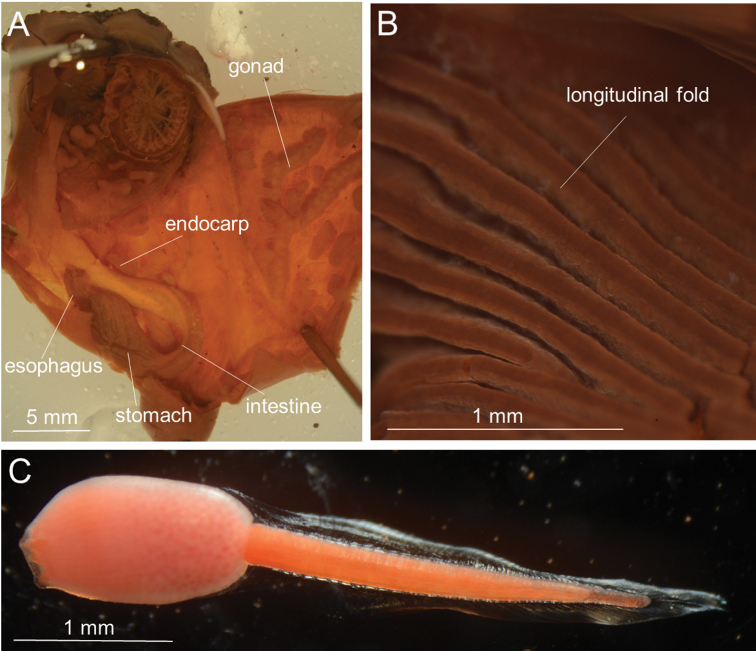
Syncarpacomposita (Tokioka, 1951). A, BICHUM 5817 CICHUM 5824. A Zooid opened dorsally, with pharynx removed B stomach internal surface C tadpole larva.